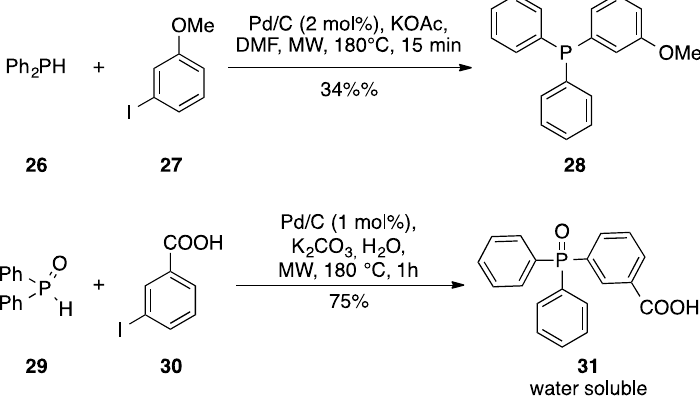
Scheme 10. Cross coupling of phosphines and phosphine